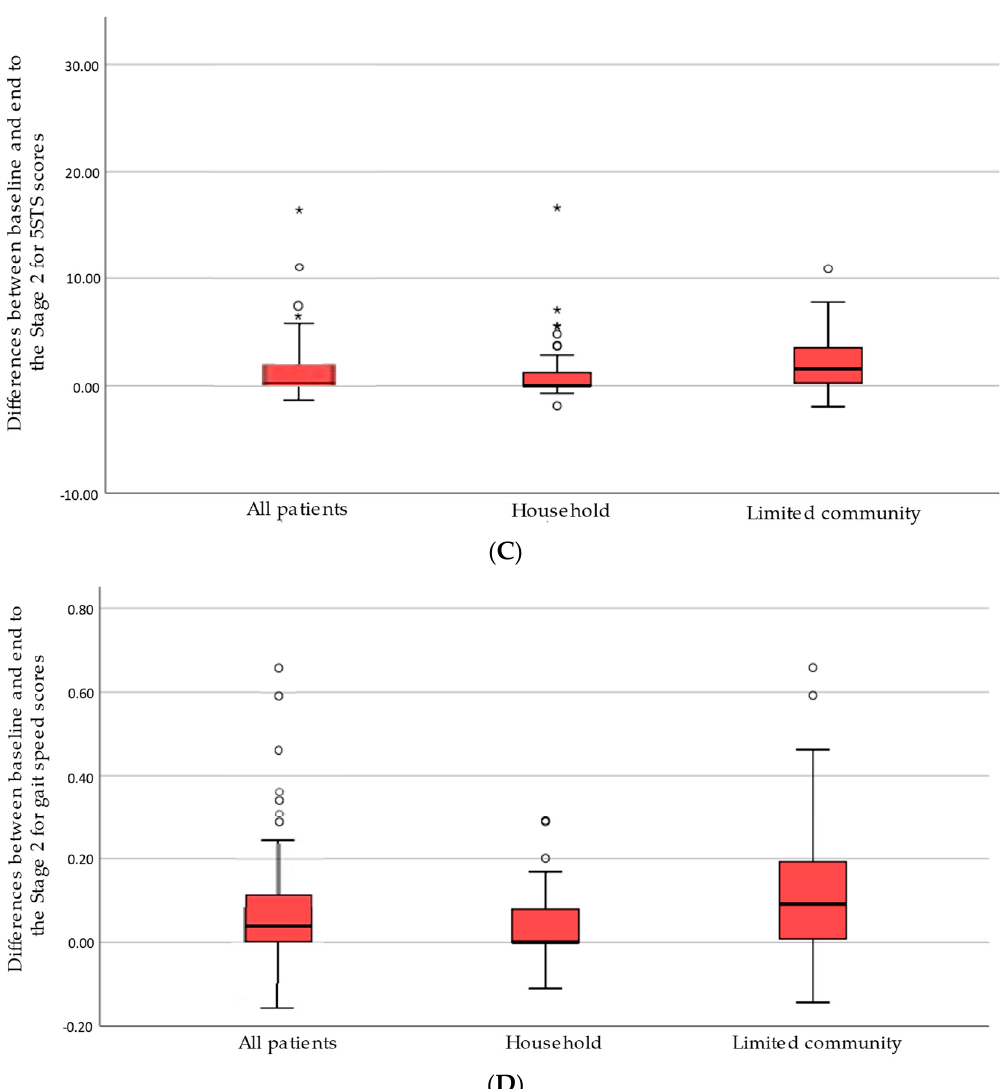
Figure 3. Boxplots of the differences between baseline and at the end of each stage of 5STS and gait speed scores in the Stage 1 ( A , B ) and in the Stage 2 ( C , D ) in all patients and by walking category.